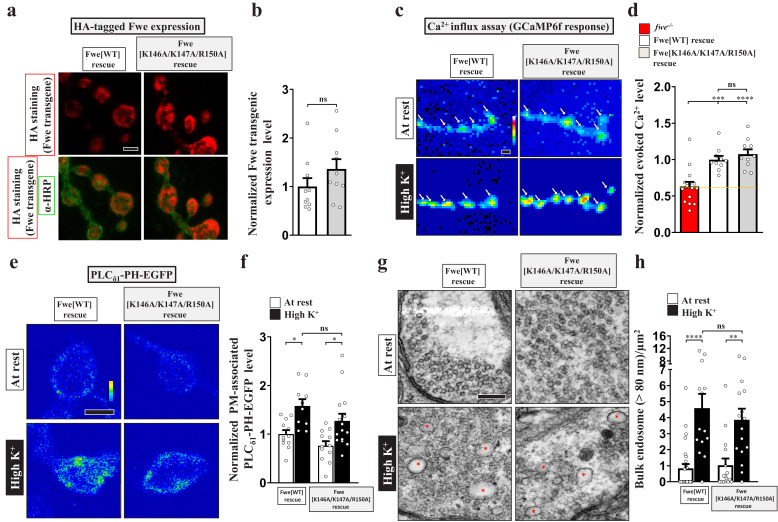
The C-terminal residues (K146/K147/R150) of Fwe are not involved in regulating Ca2+ channel activity.(a–b) Alanine substitution of the C-terminal residues K146/K147/R150 does not influence the expression or SV localization of Fwe. (a) Z-projected confocal images of NMJ boutons derived from the larvae of Flag-Fwe[WT]-HA rescue (nSyb-GAL4/UAS-Flag-Fwe-HA in fweDB25/DB56) or Flag-Fwe[K146A/K147A/R150A]-HA rescue (nSyb-GAL4/UAS-Flag-Fwe[K146A/K147A/R150A]-HA in fweDB25/DB56) lines. The larvae were reared at 25°C. α-HA (red) and α-HRP (green) staining was used to detect Fwe transgenic proteins and neuronal membranes, respectively. α-HRP staining was also used as the staining control. (b) Quantification data for the staining intensity ratio of α-HA to α-HRP, normalized to the value of the Flag-Fwe[WT]-HA rescue line. (c–h) Alanine substitution of the C-terminal residues K146/K147/R150 does not influence Ca2+ channel activity and the ability to induce PI(4,5)P2 microdomains and ADBE. (c) Snapshot Ca2+ images of the NMJ boutons. fwe-/- (fweDB25/DB56). The boutons were subjected to 5 min stimulation of 90 mM K+/2 mM Ca2+. The images were taken in the fifth minute. Evoked Ca2+ levels are represented as the increase in GCaMP6f fluorescence in response to high K+ stimulation. (d) Quantification data for evoked Ca2+ level, normalized with the value of the Flag-Fwe[WT]-HA rescue line. (e) Single-plane confocal images of the NMJ boutons. The boutons were subjected to the resting condition (10 min incubation of 5 mM K+/0 mM Ca2+) or high K+ stimulation (10 min stimulation of 90 mM K+/2 mM Ca2+), followed by chemical fixation and α-GFP immunostaining. (f) Quantification data for the PLCδ1-PH-EGFP staining intensity, normalized to the value of the resting condition of the Flag-Fwe[WT]-HA rescue line. (g) TEM images of NMJ boutons. TEM processing was performed under the following conditions: at rest (10 min incubation of 5 mM K+/0 mM Ca2+); or high K+ (10 min stimulation of 90 mM K+/2 mM Ca2+). Bulk endosomes (red asterisks). (h) Quantification data of total numbers of bulk endosomes per bouton area. Individual data values are shown in the graphs. p values: ns, not significant; *p<0.05; **p<0.01; ***p<0.001; ****p<0.0001. Mean ± SEM. Scale bar: 2 µm (a, c, e), 500 nm (g). Statistics: Student t-test (b). One-way ANOVA with Tukey’s post hoc test (d, f, h).
Figure 4—figure supplement 1—source data 1.Source data for Figure 4—figure supplement 1.